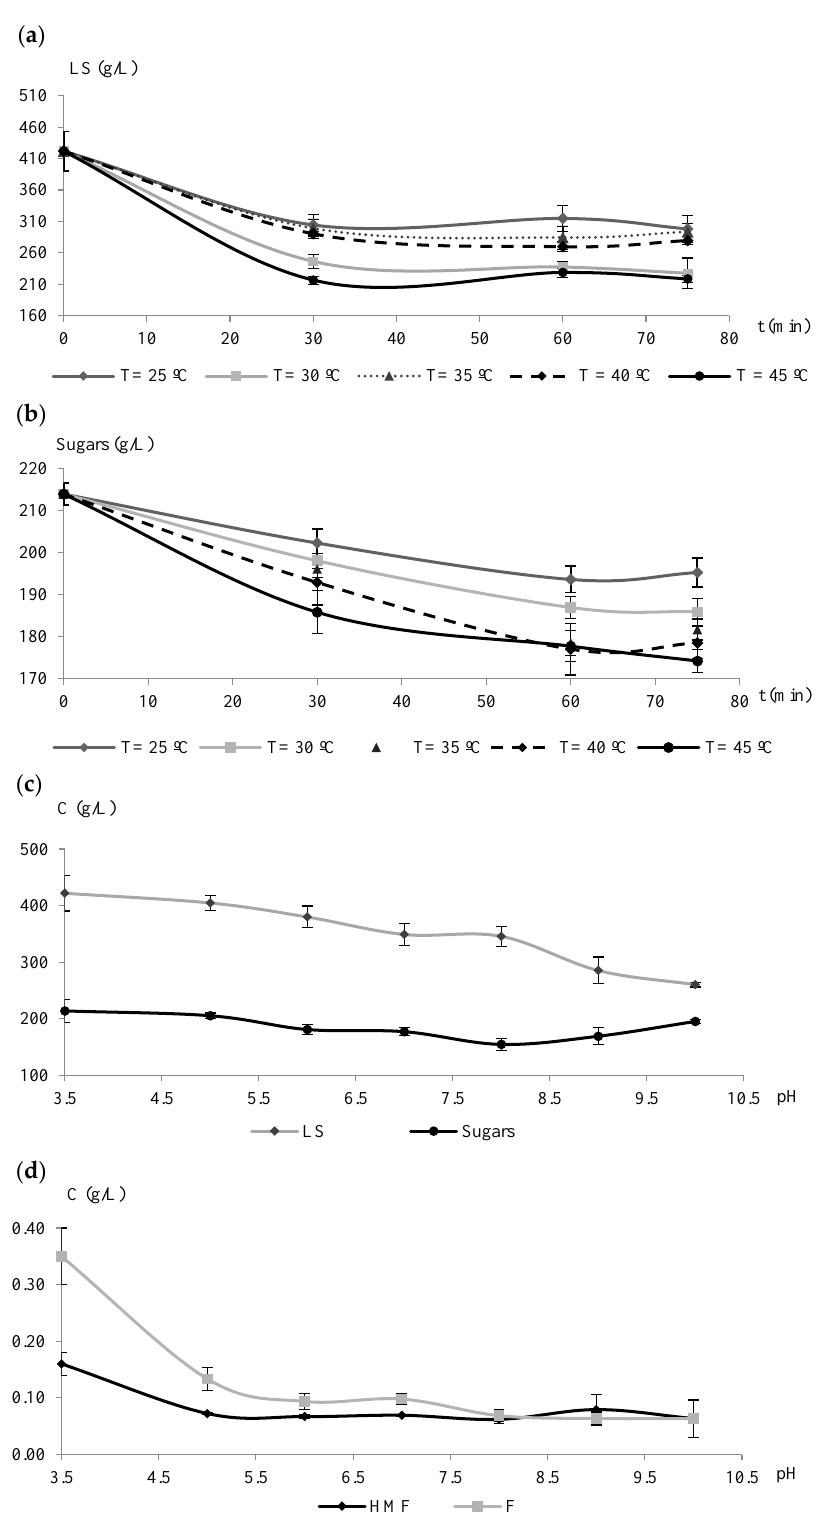
Figure 2. ( a ) Variation in time and temperature over lignosulfonate detoxification; ( b ) and the sugar losses in the hydrolyzates; ( c ) Effect of pH over lignosulfonates and sugar; ( d ) and furfural concentration.